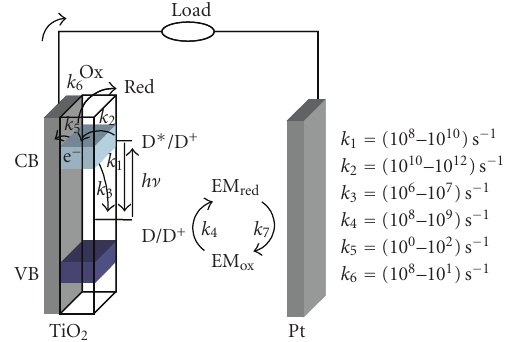
Figure 1: Electron transfer processes involved in a DSSC and their time